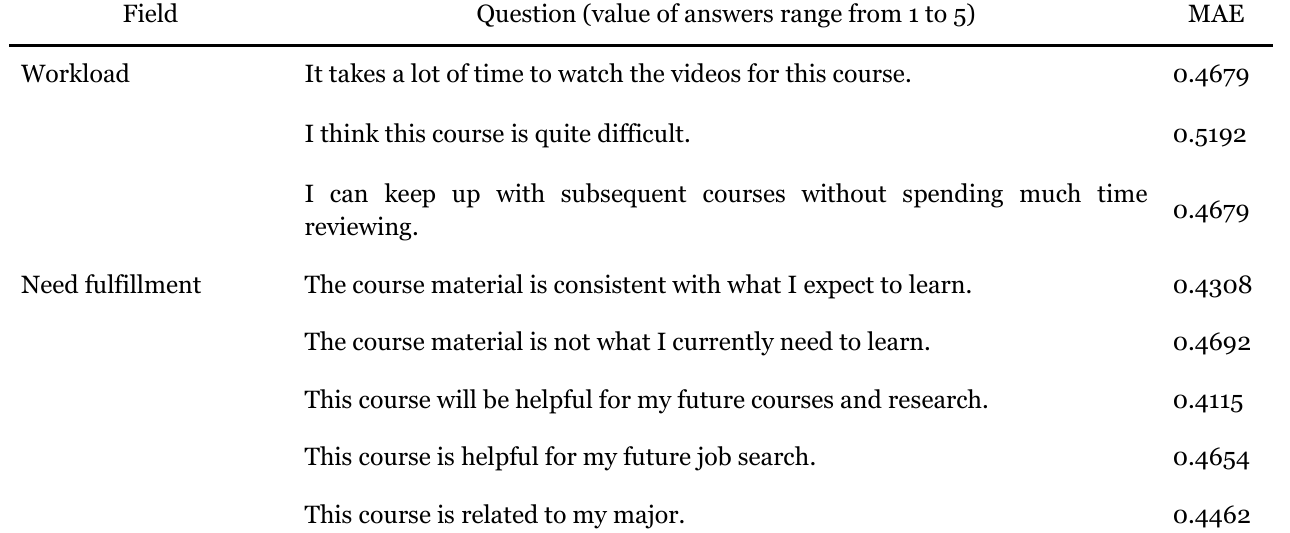
Table 6 Predictive Performance Field Question (value of answers range from 1 to 5)